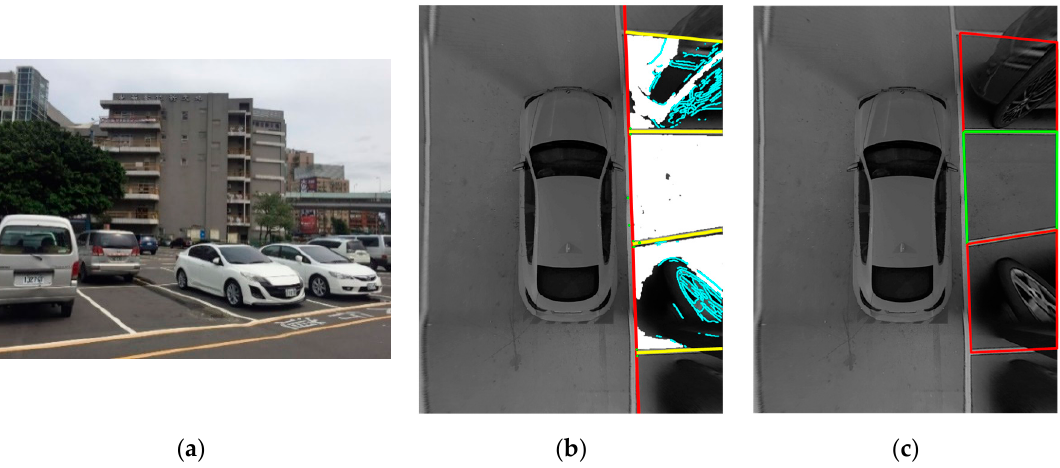
Figure 23. Experimental results in the Guang Hua Digital Plaza parking lot. ( a ) Experimental setting; ( b ) Detection process; ( c ) Detection results.